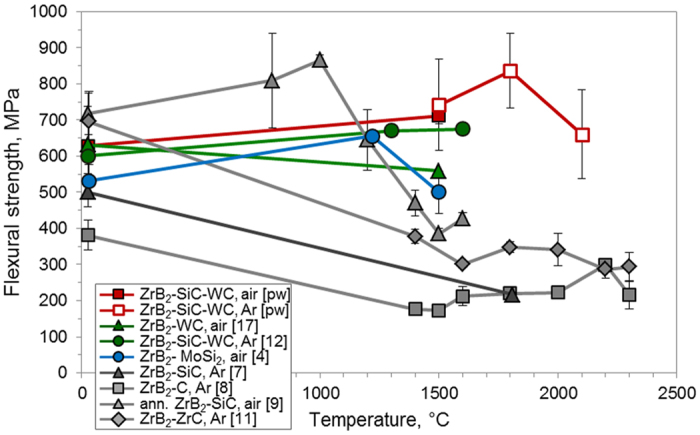
Flexural strength as a function of temperature for the highest strength ZrB2-ceramics41217, or tested at the highest temperatures in air or Argon78911. pw: present work.